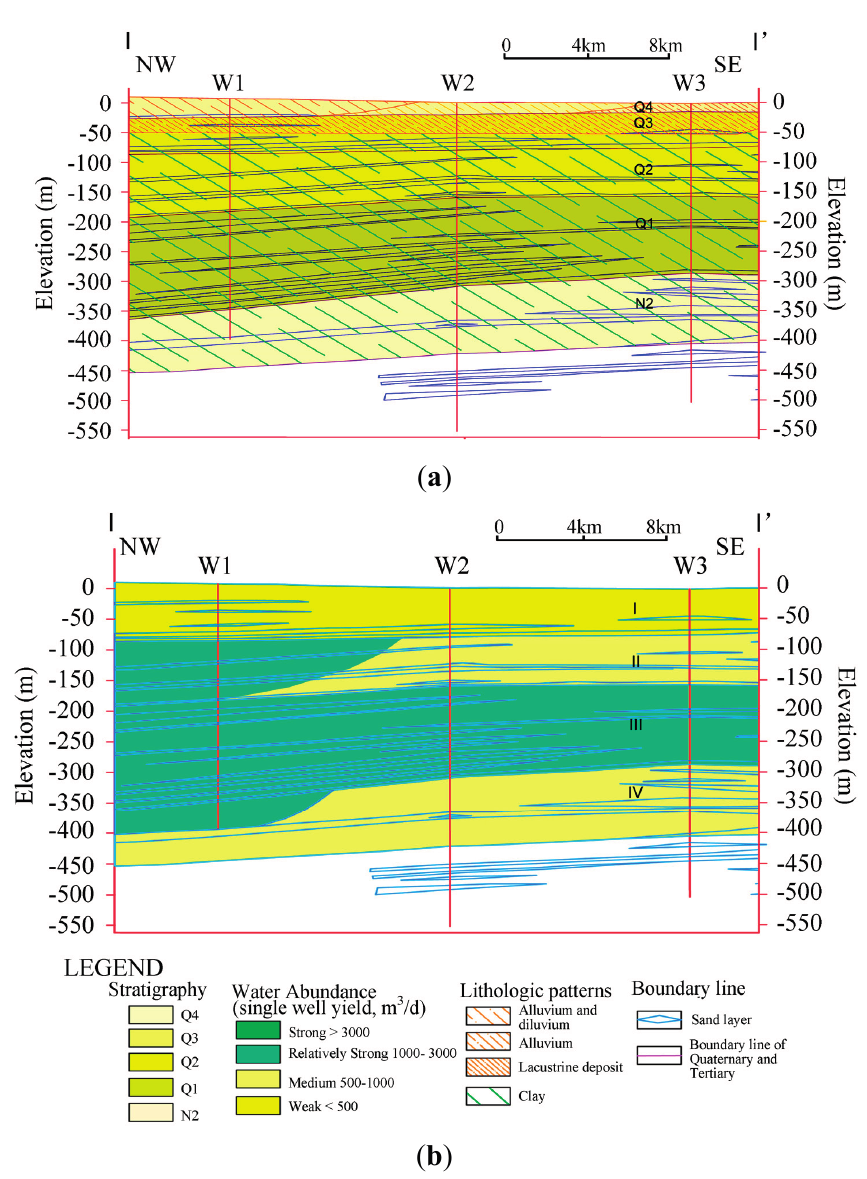
Figure 9. Geological and hydrological map. In Figure 2, the geological profile is marked with white line and three drilling locations are marked as W1, W2 and W3. ( a ) Geological profile map. W1 is located in Wangqingtuo Town. The legend is the same as that of ( b ). (b) Hydrological